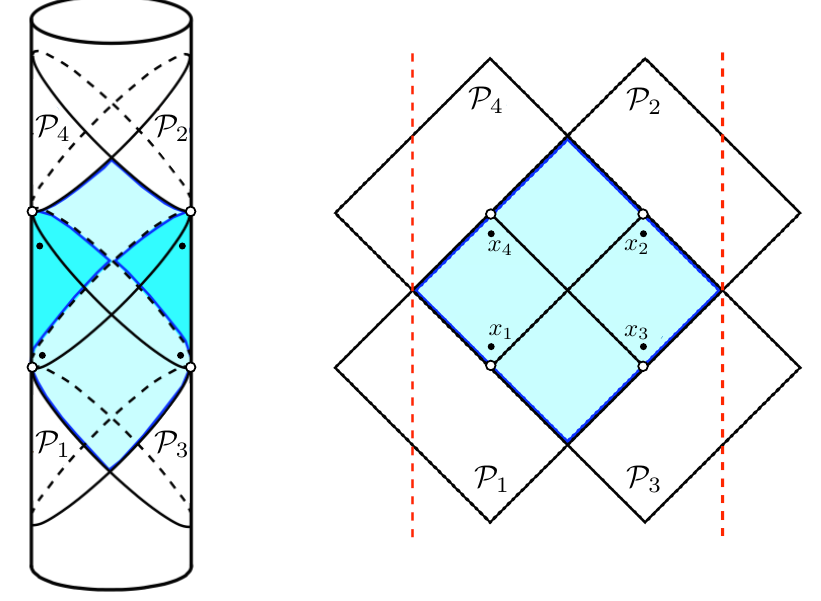
Figure 3 . The CFT can be de(cid:12)ned on the Lorentzian cylinder (left (cid:12)gure). By a conformal trans- formation one can move to a Poincar(cid:19)e patch, de(cid:12)ning the theory on Minkowski space, that covers only a portion of the cylinder. The central Poincar(cid:19)e patch, where operator insertions are close to null in(cid:12)nity, is shown in blue. One may instead consider Poincar(cid:19)e patches whose origins, shown as white dots, are at null in(cid:12)nity of the central Poincar(cid:19)e patch. The operator is then inserted very close to O i the origin of the Poincar(cid:19)e patch , where we use coordinates x i . To visualize the di(cid:11)erent Poincar(cid:19)e P i patches it is convenient to open the cylinder (right (cid:12)gure). The red lines are identi(cid:12)ed in this